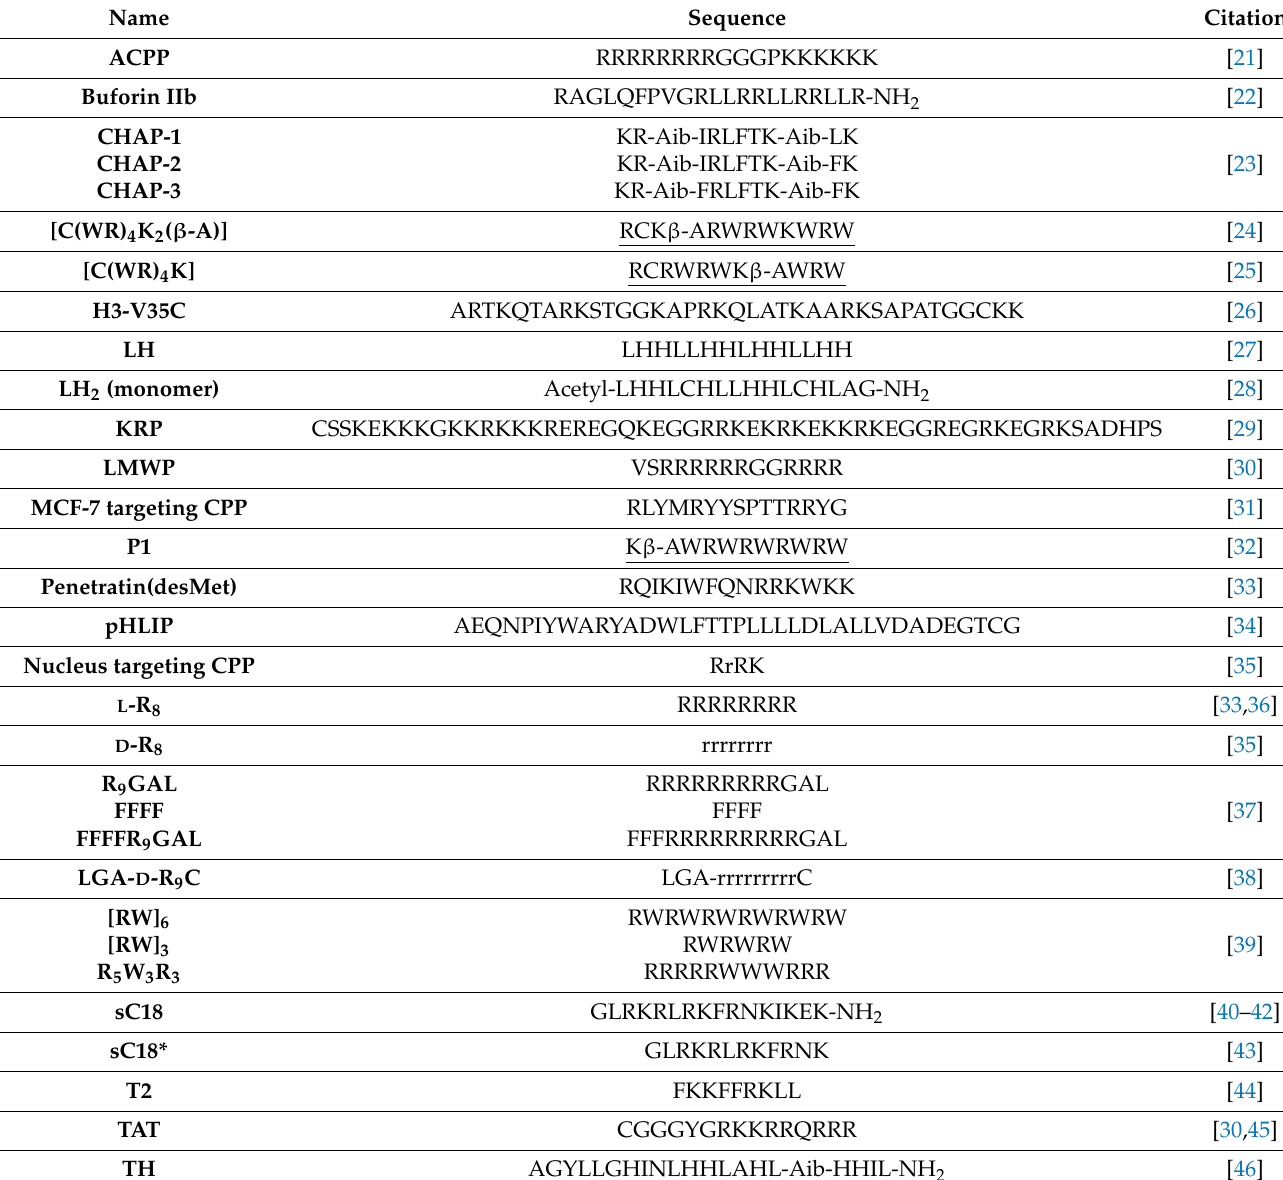
Table 1. Overview of the cell-penetrating peptides (CPPs) discussed within this review. Underlined sequences describe cyclization; small letters stand for the D -conformation of the respective amino acids; Aib: 2-aminoisobutyric acid; K β -A: beta-alanine is coupled to the ε -NH 2 group of lysine via amide